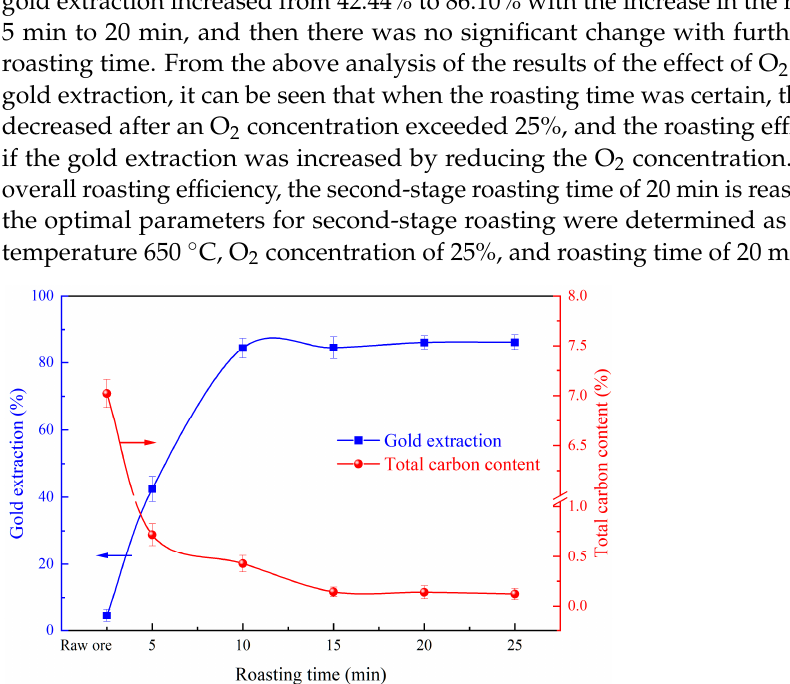
Figure 9. Gold chemical phase analysis results of the raw ore and the roasted product under optimal conditions.